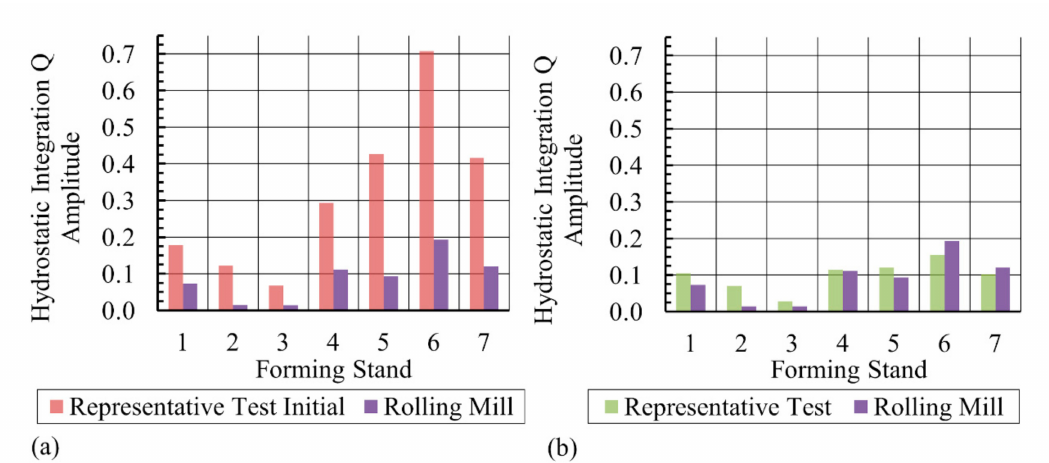
Figure 10. ( a ) Q amplitude per stand comparison between the initial representative test and the rolling mill and ( b ) between the corrected representative test and the rolling